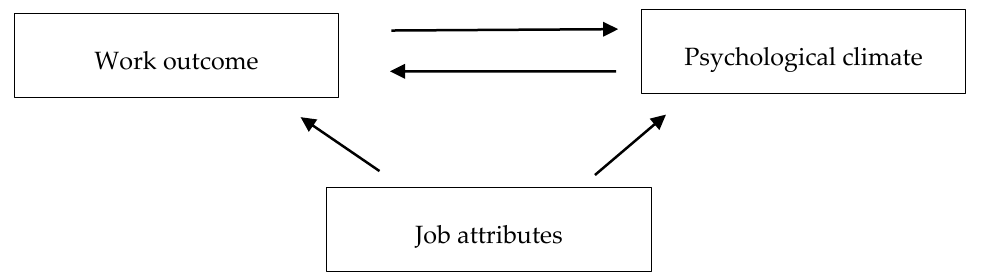
Figure 1. Model relating psychological climate and individual work outcomes.